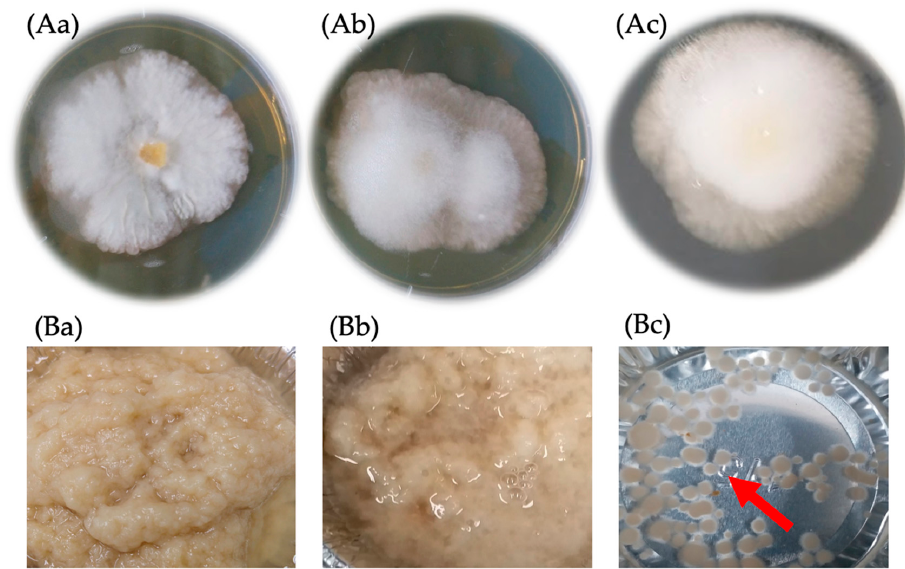
Figure 1. Total Fatty acid profile of M. alpina FU30797 after 5 days of cultivation.